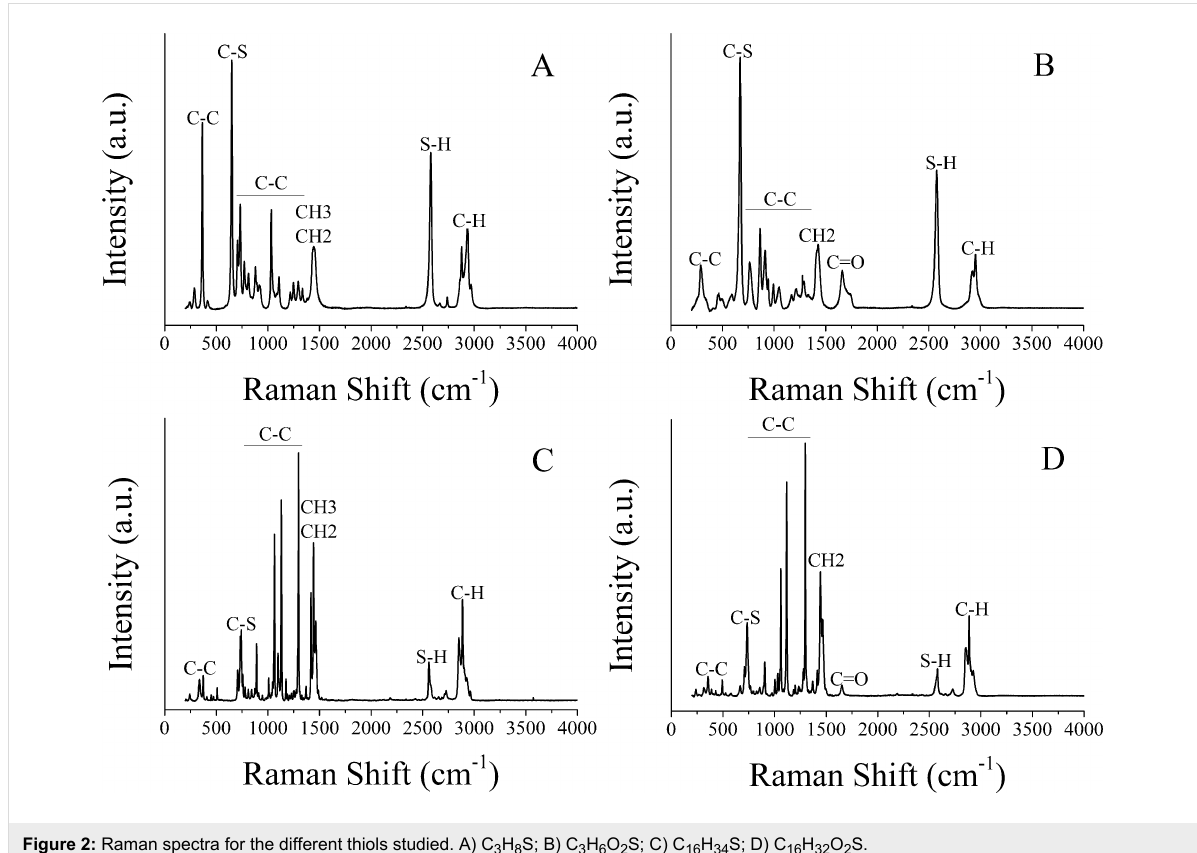
Figure 2: Raman spectra for the different thiols studied. A) C 3 H 8 S; B) C 3 H 6 O 2 S; C) C 16 H 34 S; D) C 16 H 32 O 2 S.